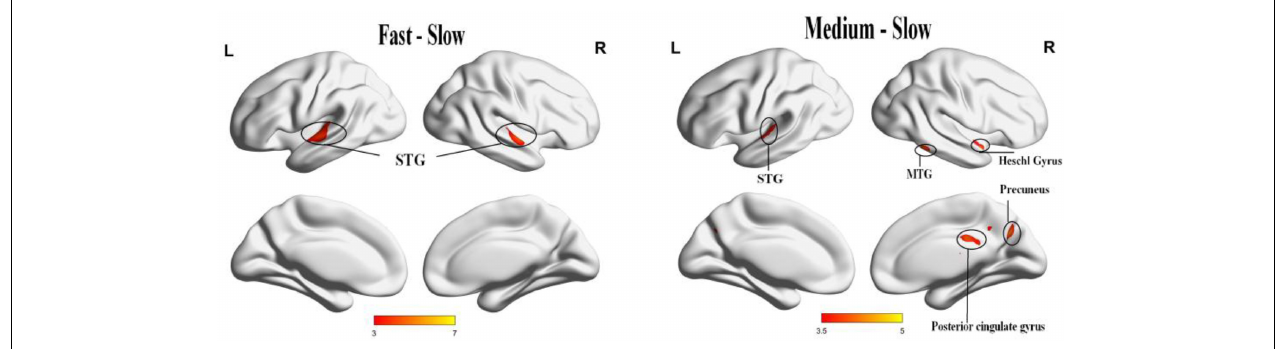
FIGURE 5 | The panel (Left) result of comparison shows the positive activation of fast music to slow music in bilateral STG. The panel (Right) result of comparison shows the positive activation of medium music to slow music in right HG, right precuneus, right MTG, right PCC, right IPL, left STG, and left